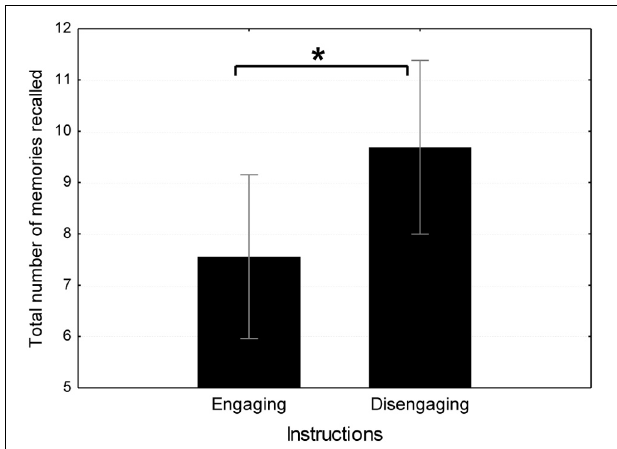
FIGURE 4 | Total number of memories recalled in emotionally engaging instruction conditions in Study 2. ∗ p < 0 . 05